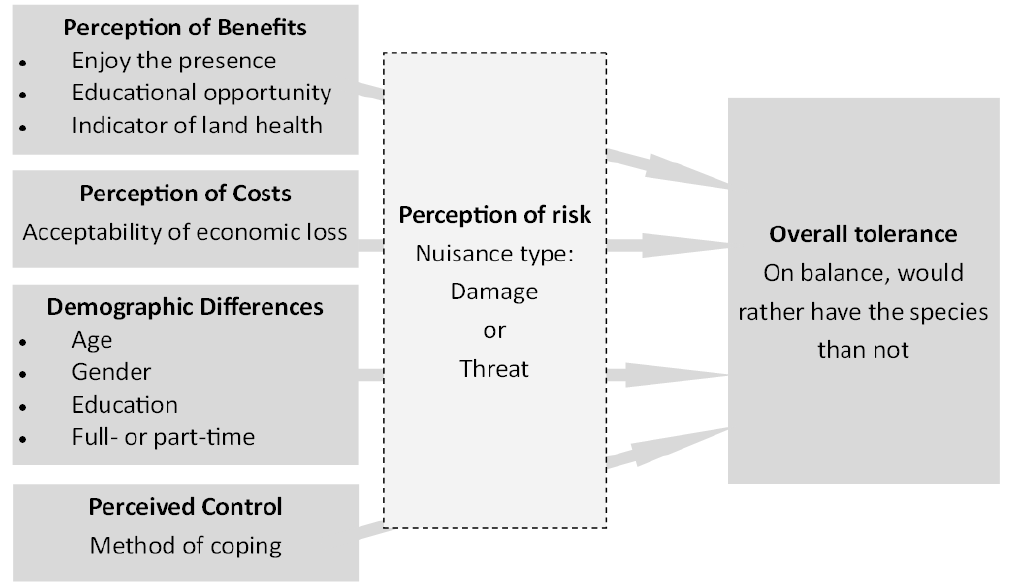
Figure 1. Theoretical framework guiding survey design and